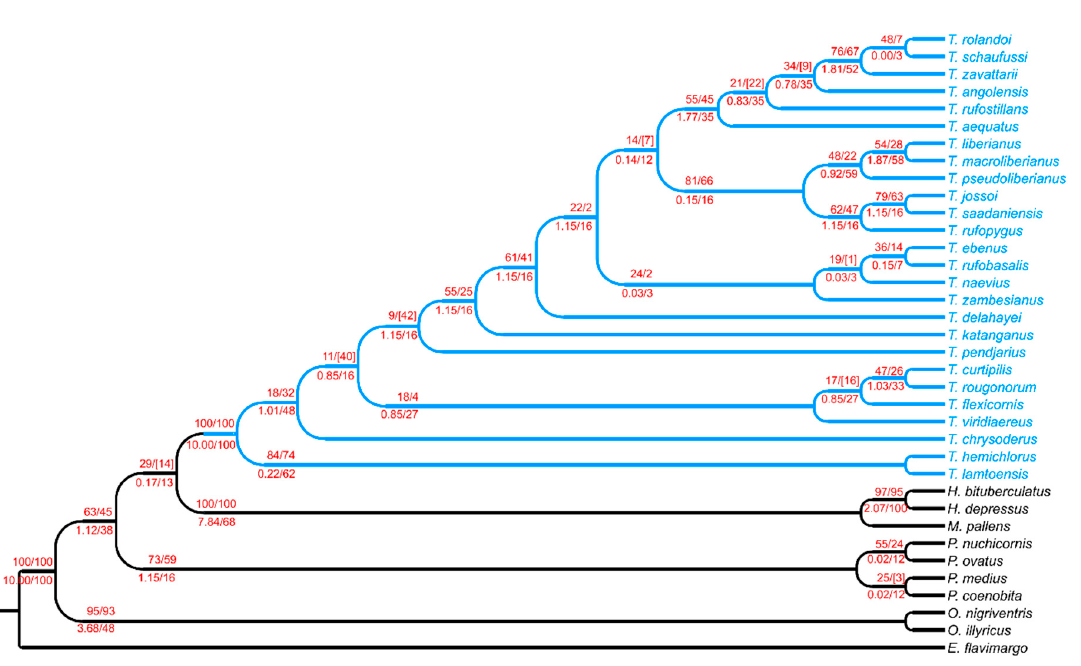
Figure 3. Tree from the phylogenetic analysis with the branch supports. Below branches: Bremer supports and relative Bremer supports. Above branches: symmetric resampling (P = 33), and the difference in support measured using frequency differences between the most frequent group and the most frequent contradictory group (GC values). The resulting values of jackknifing (P = 36), and standard bootstrap values were analogous to the symmetric resampling ones. Calculated tree statistics: tree length = 260.343, adjusted homoplasy = 15.108, consistency index = 0.462, retention index = 0.724, scores for 247 landmark points = 64.343.